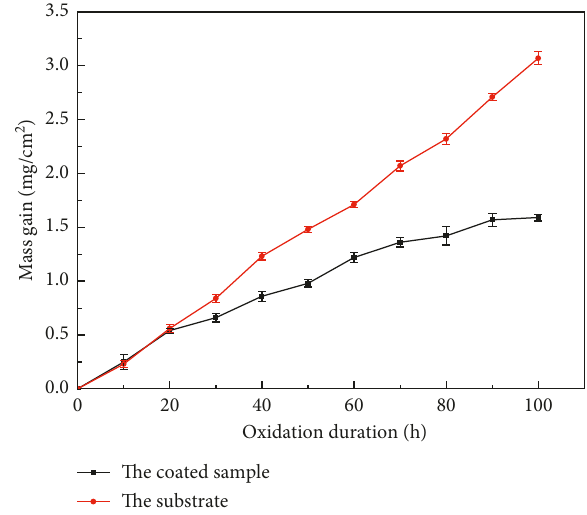
Figure 10: Oxidation kinetics curves of Ti alloy with and without coating at 1073 K for 100h (10 cycles).